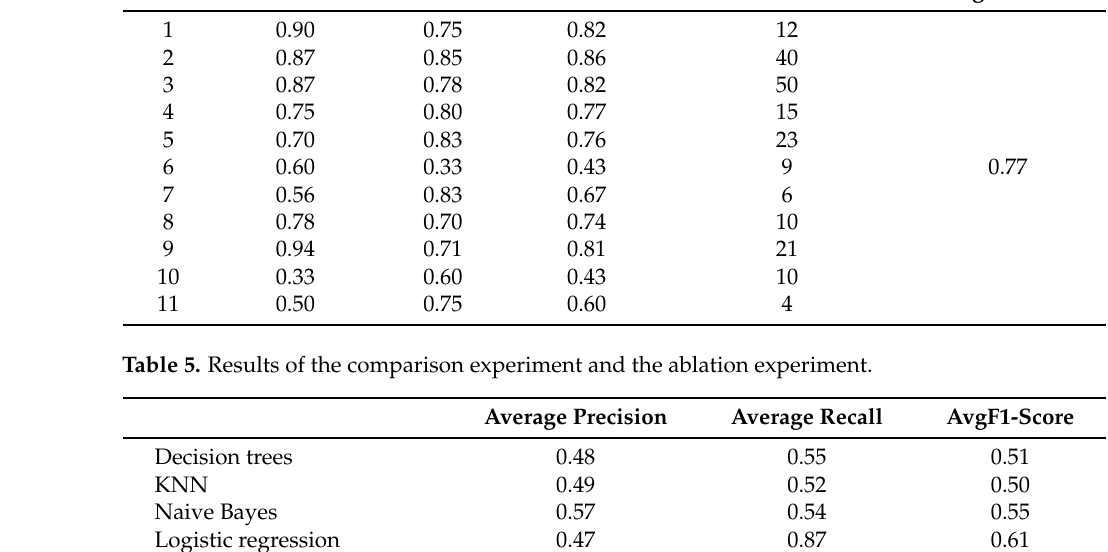
Table 4. Corresponding procedure for calculating the average F1-score of Fold 4. Precision Recall F1-Score Number of Cases